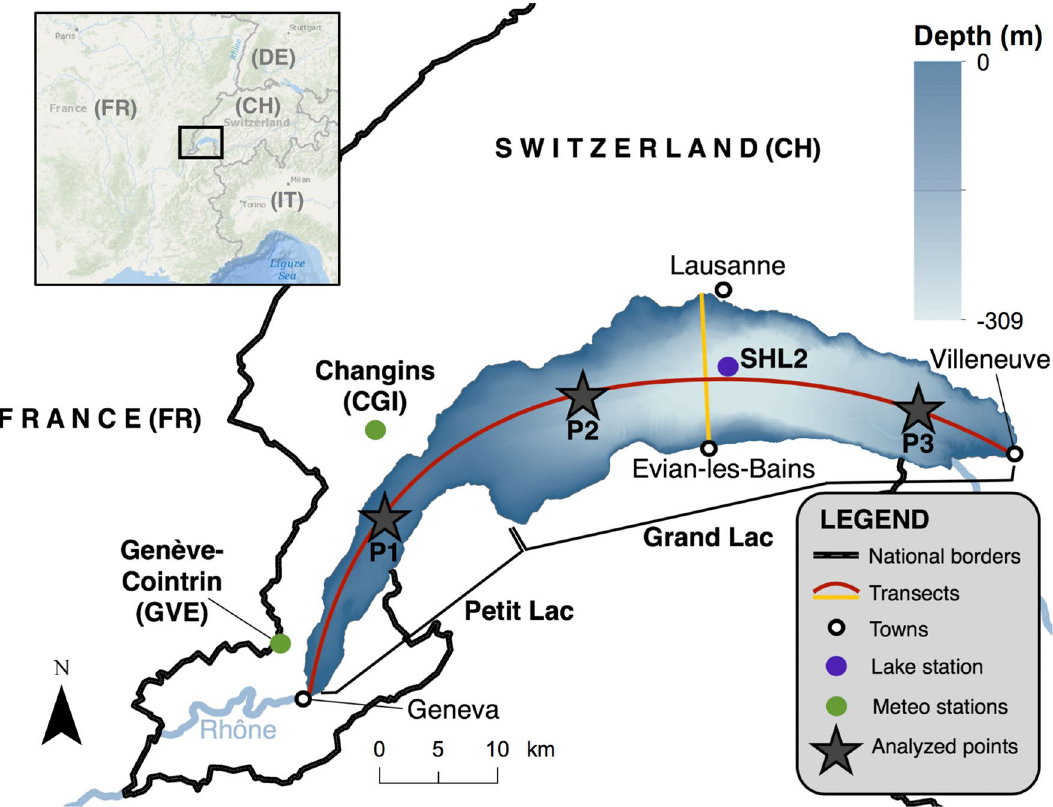
Figure 1. Study site. The yellow and red curves correspond to the N–S and W–E transects, control point P1 is located in the “Petit Lac”, whereas points P2 and P3 are located in the “Grand Lac”. Coordinates for upper right corner: 46.76° N/6.95° E and for lower left corner: 46.12° N/5.90° E. Map generated with ArcGis 24